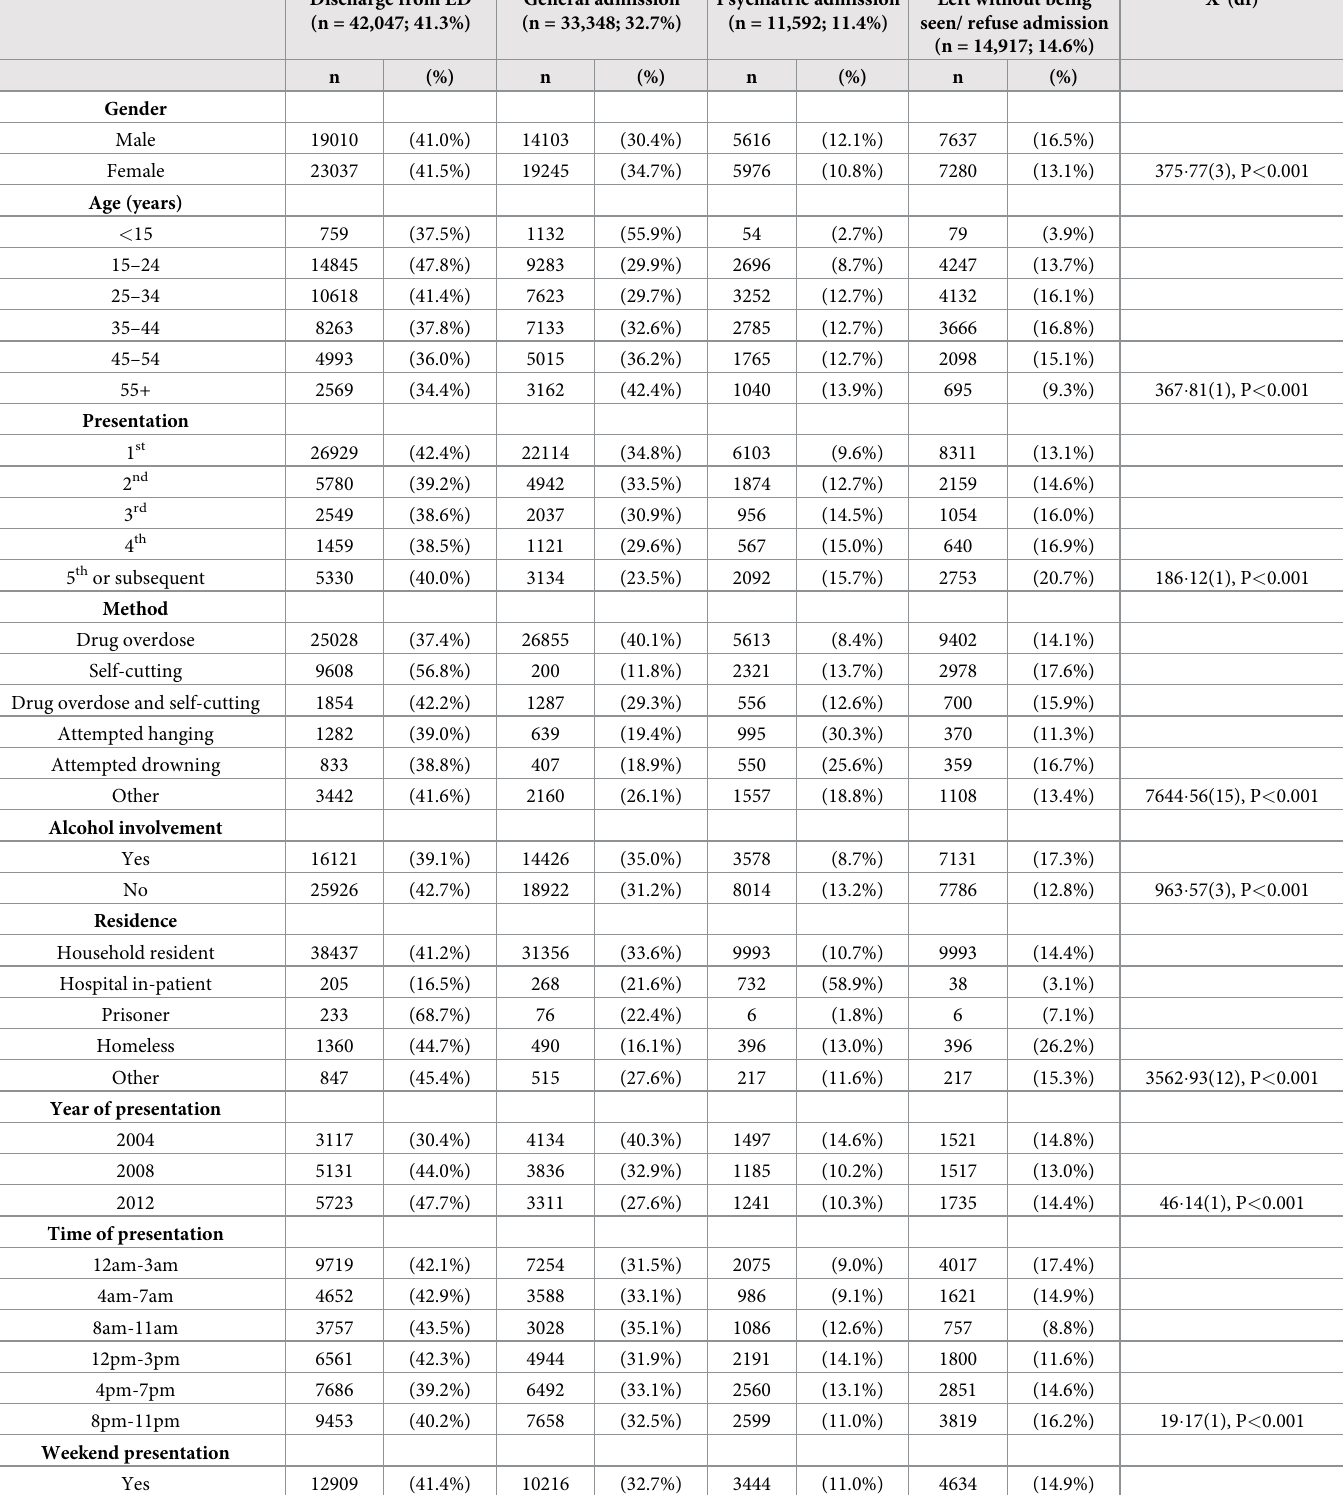
Table 1. Demographic and clinical characteristics according to recommended next care